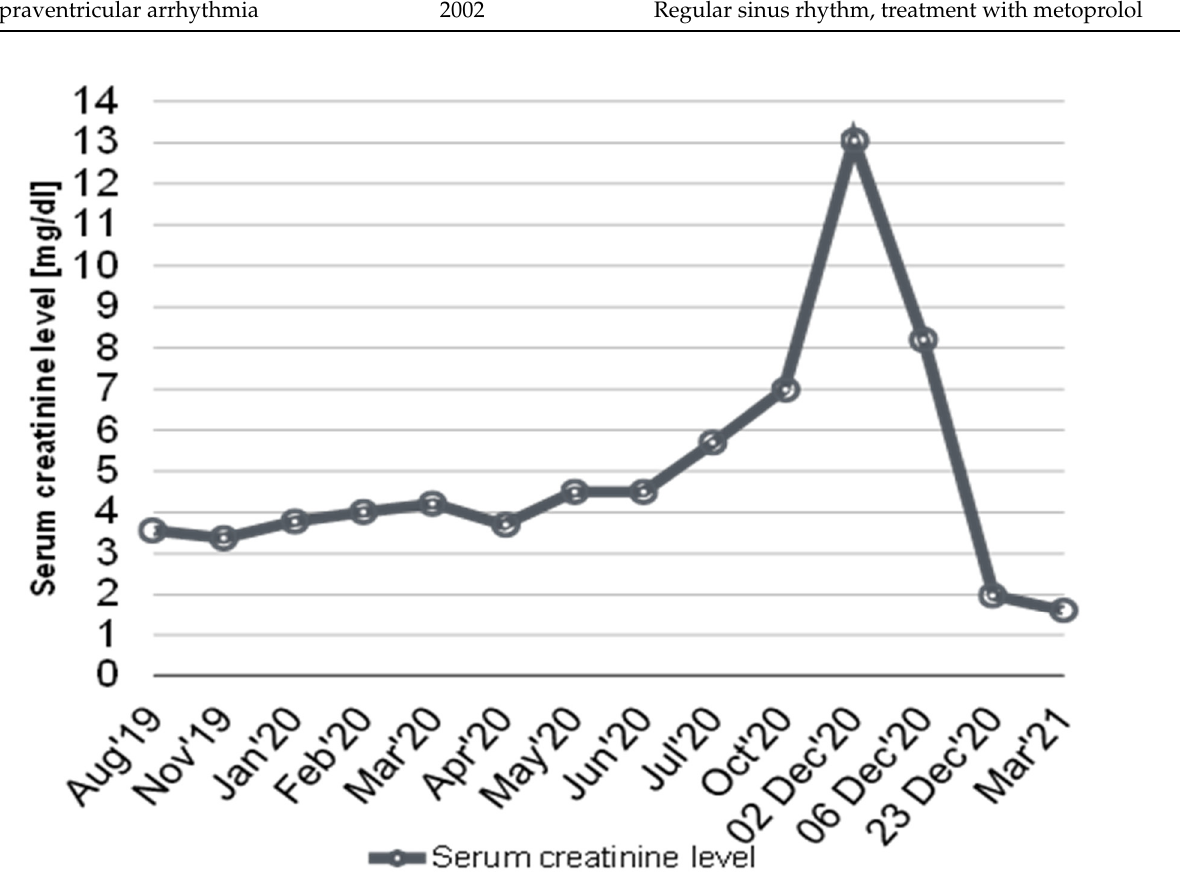
Figure 1. Serum creatinine level throughout the re-transplantation process.